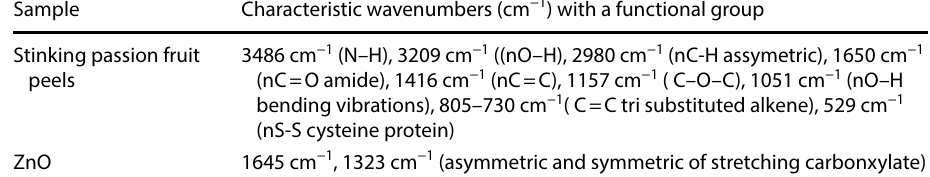
Table 2 FTIR of Stinking passion fruit peel and ZnO nanoparticles